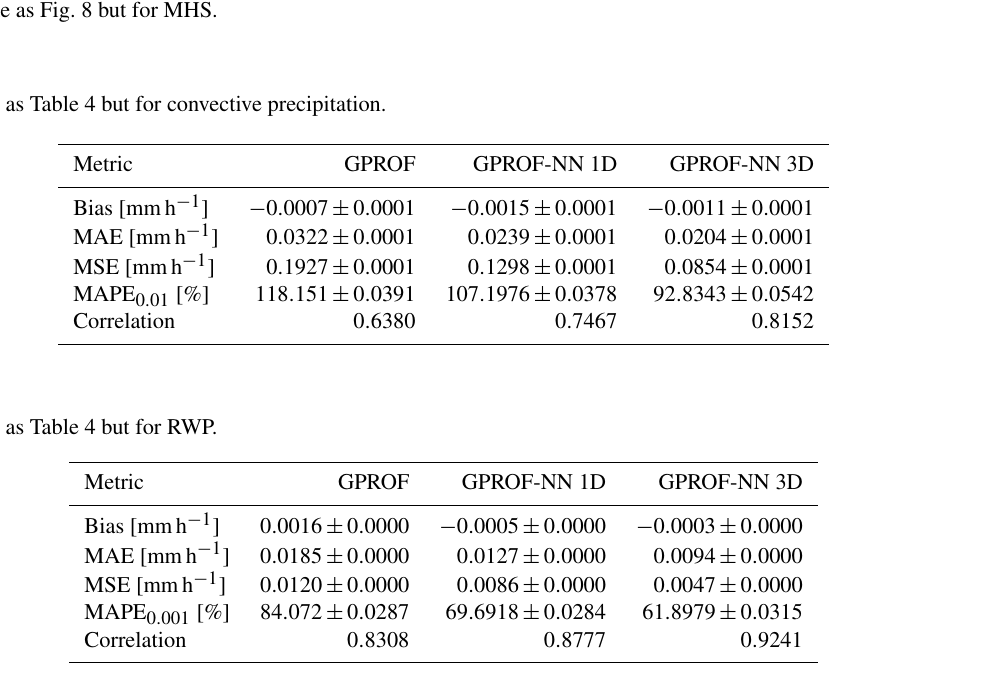
Figure C1. The same as Fig. 8 but for MHS.